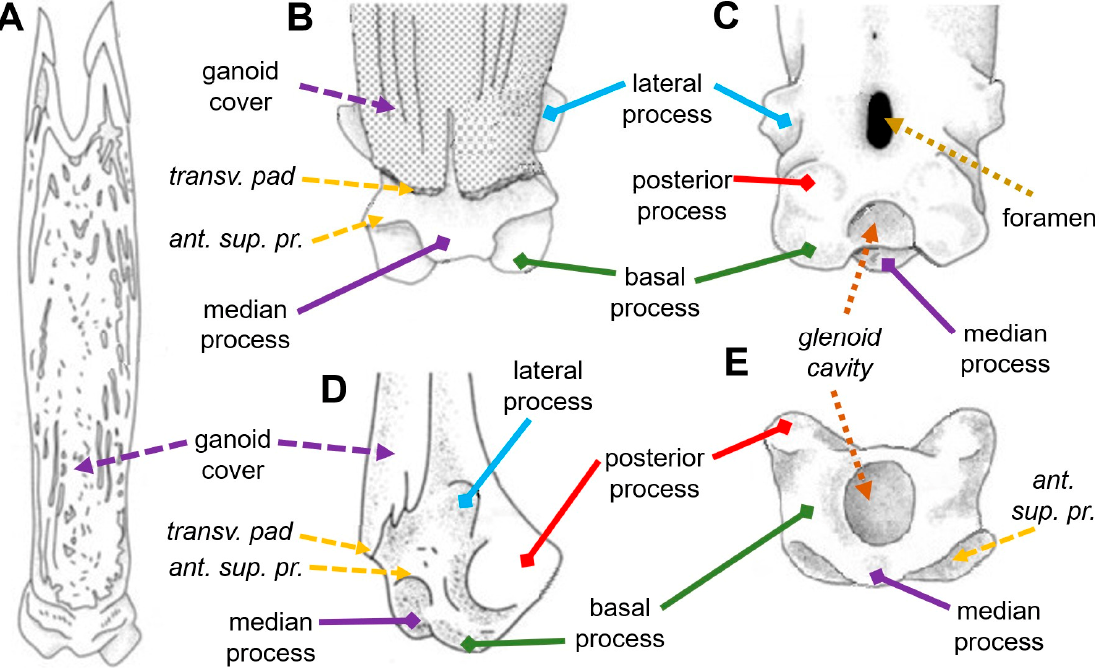
Figure 1. Illustration of the anatomical details on the anterior ( A , B ), posterior ( C ), lateral ( D ), and anterior ( E ) views of a pinnule (modified from Gayet and Meunier, 2020). The plain lines identify diagnostic structures. trans. pad for transversal pad; ant. sup. pr. for anterior transversal